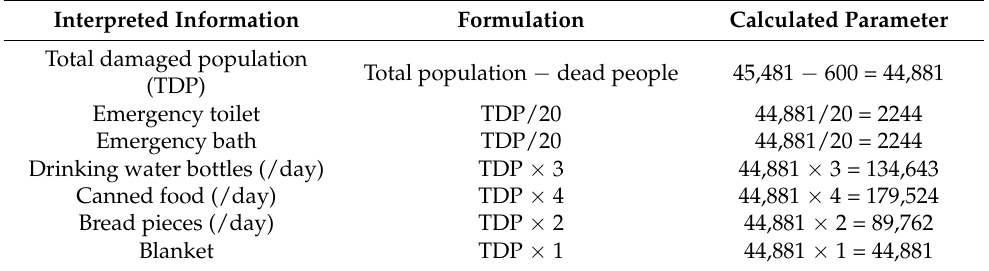
Table 5. Formulation of required resources based on Sphere, 2004 and Bam earthquake report estimation